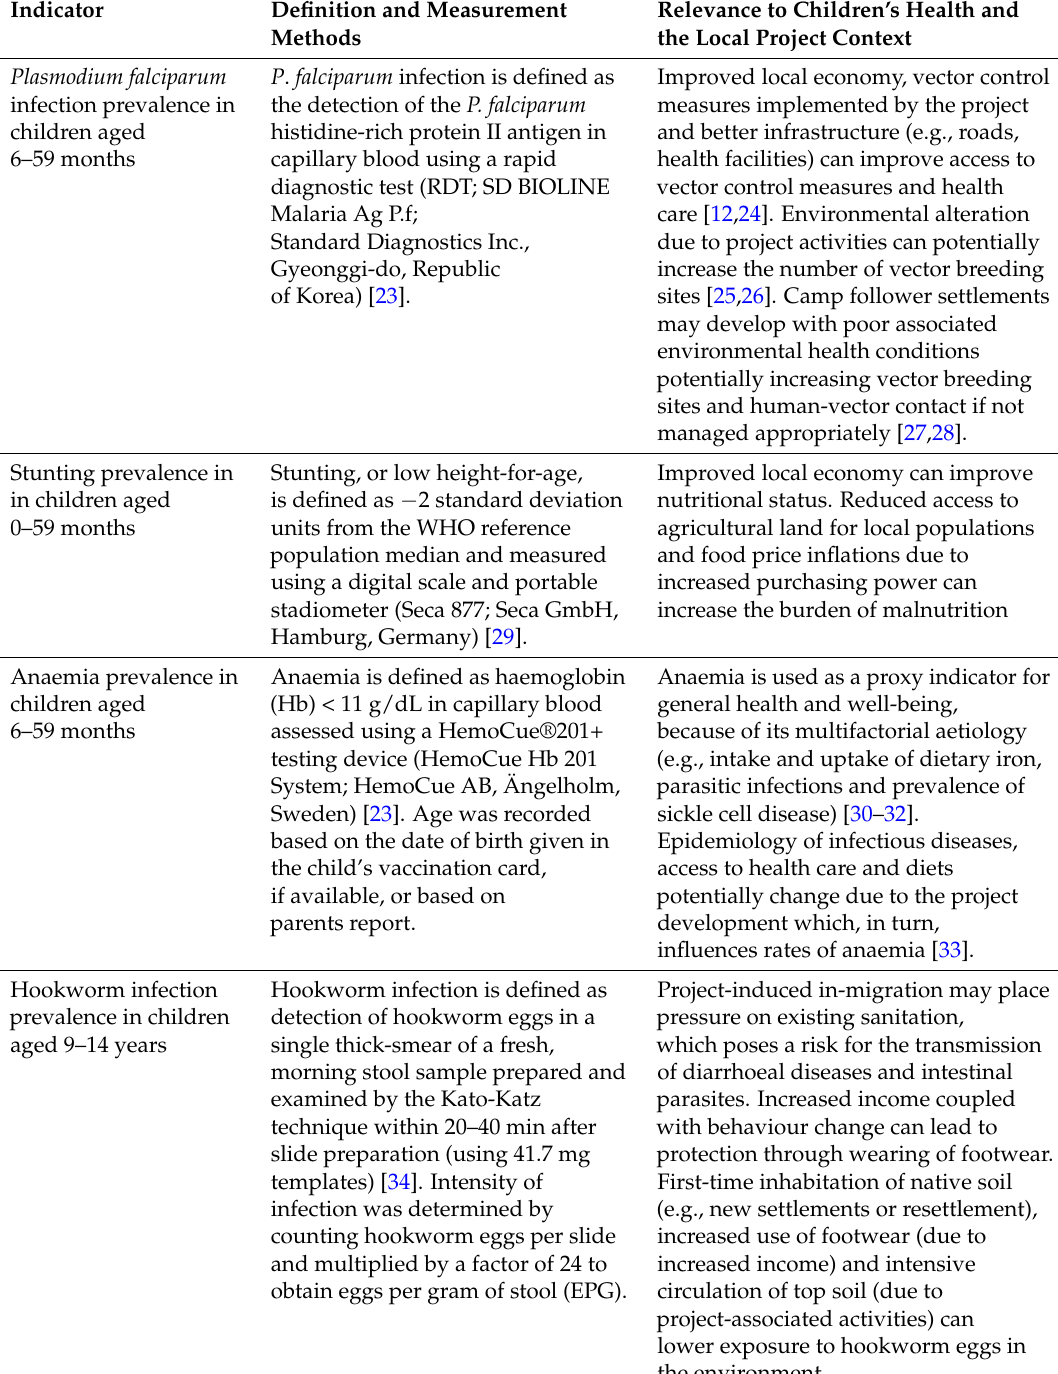
Table 1. Selected indicators in children and their relevance in the Trident copper mining project area,